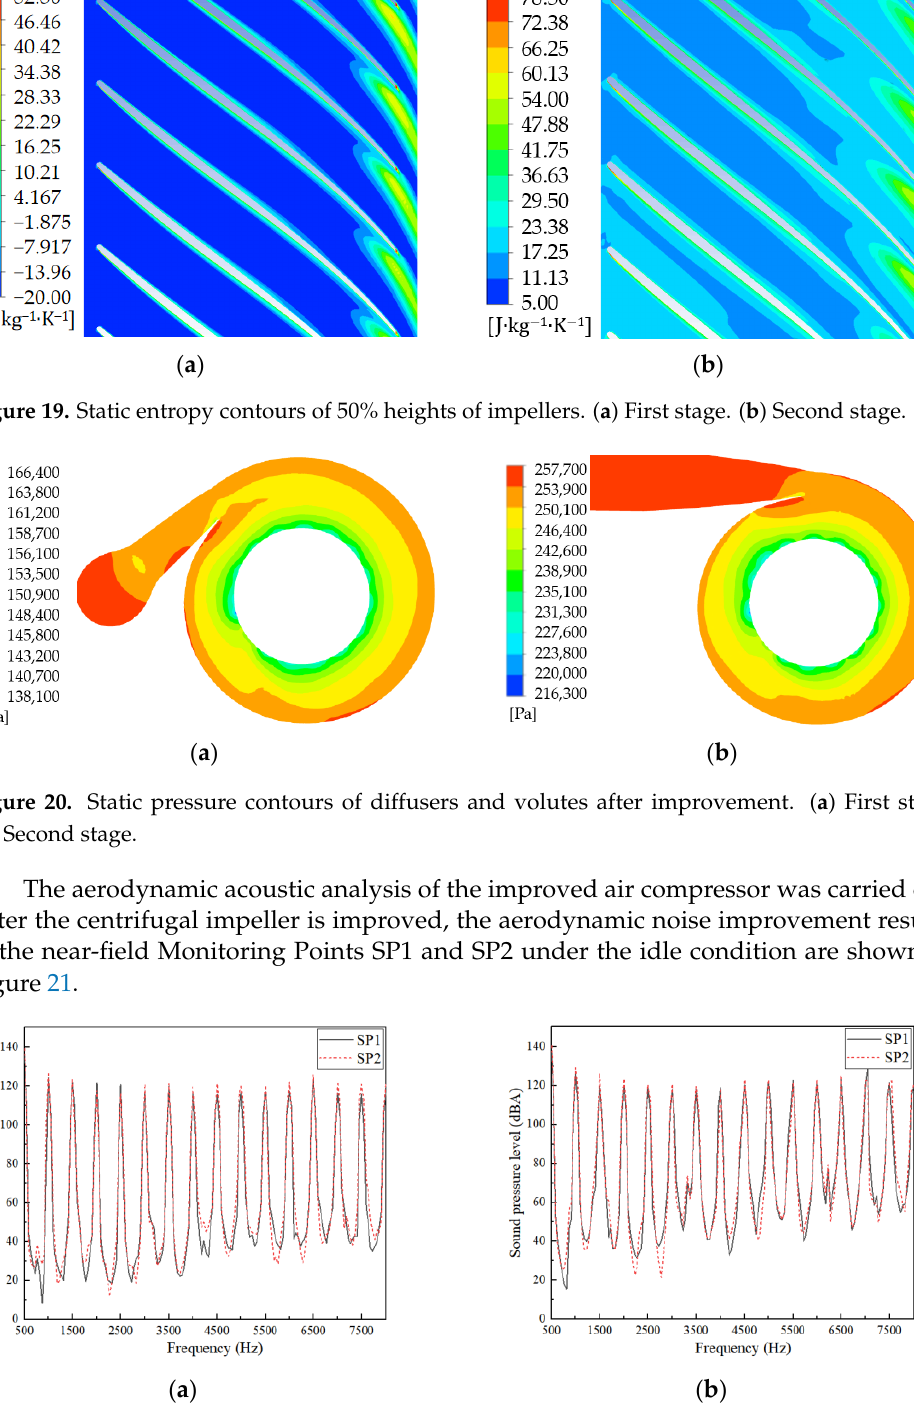
Figure 21. Noise spectrum before and after improvement under idle condition. ( a ) SP1. ( b ) SP2.